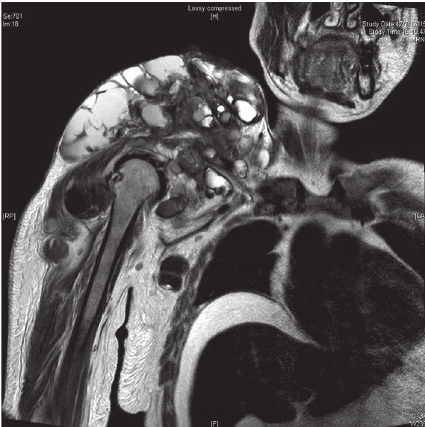
Figure 2: Magnetic resonance imaging (T2-weighted) of the right